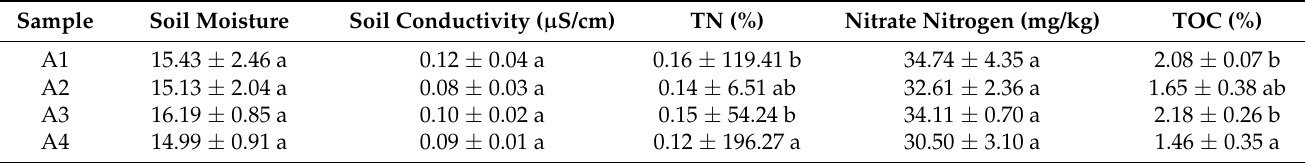
Table 3. Basic physical and chemical properties of soil.